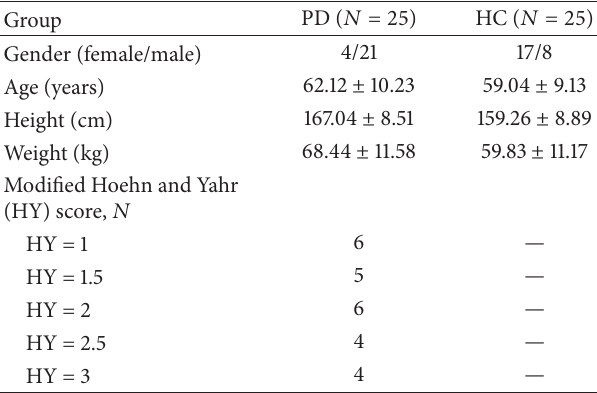
Table 1: Characteristics of the study